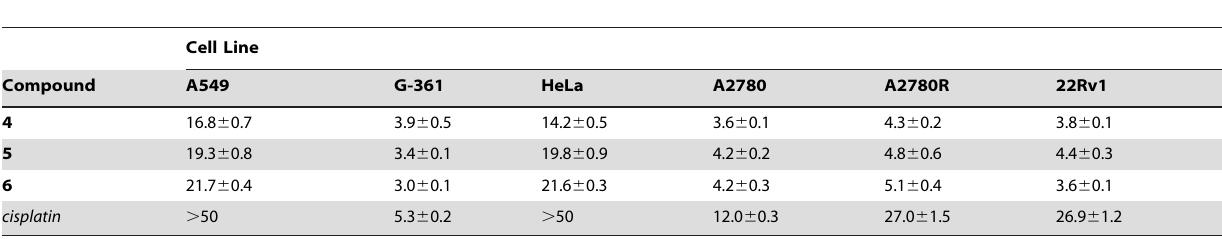
Table 3. In vitro cytotoxicity of complexes 4–6 and cisplatin against a panel of cancer cell lines.